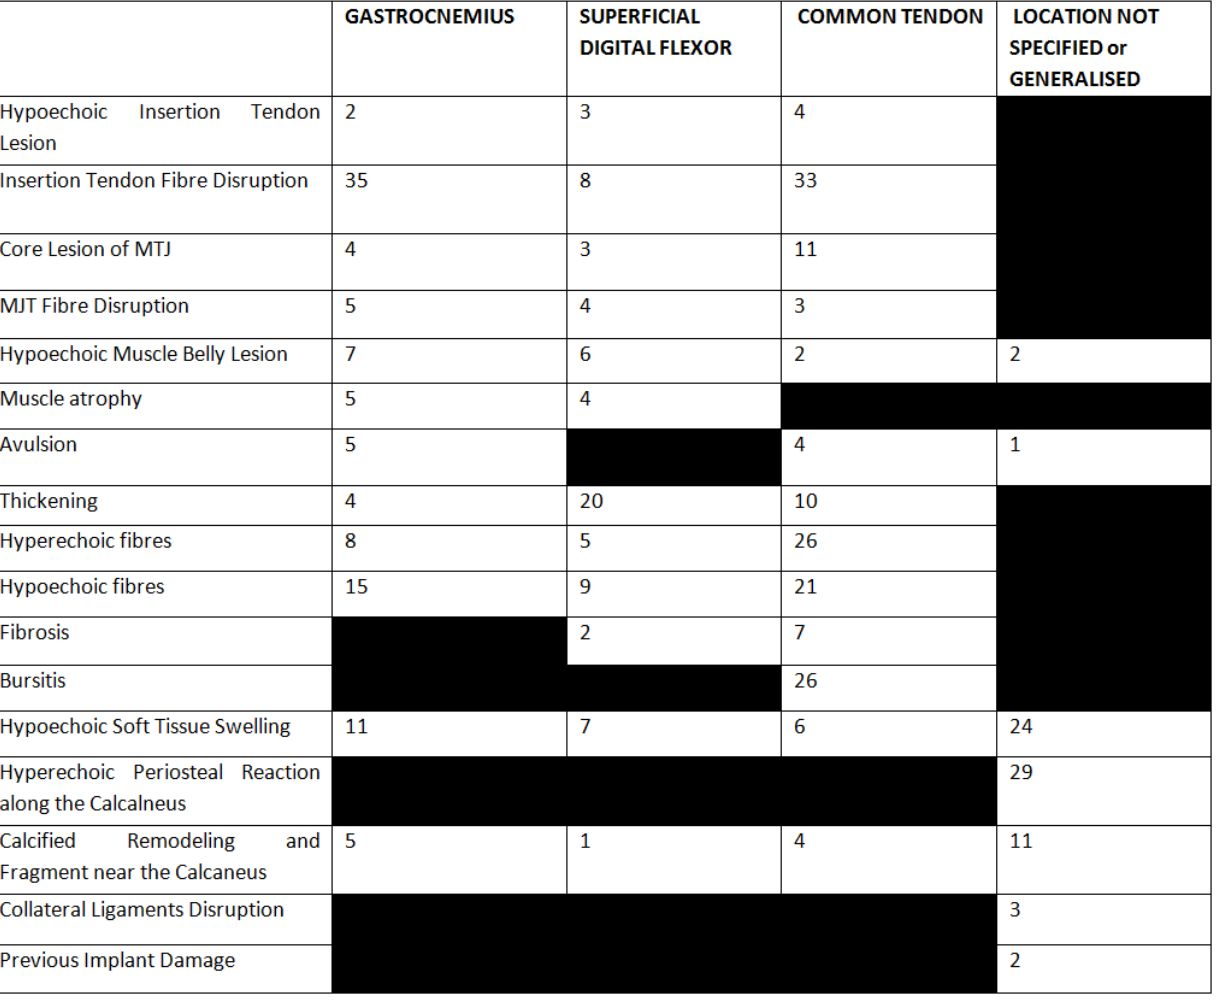
Table S1 : Description of Every Achilles Tendon Injuries Noted on Diagnostic Ultrasound *The total number of lesions analy s ed does not correspond to the number of patients included in this study. One patient may have had injuries to multiples components of the Achilles tendon which may have been described using diverse